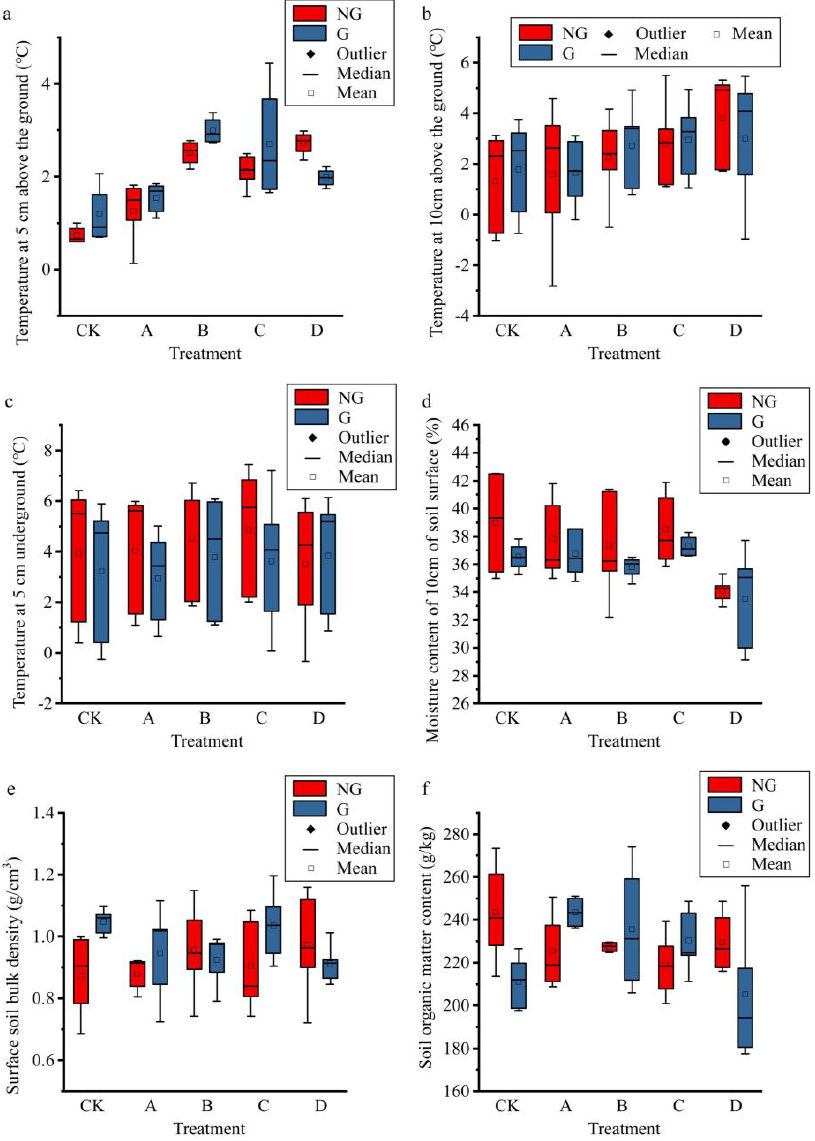
Figure 1. Changes in environmental factors in experimental treatments. ( a ), temperature at 5 cm aboveground; ( b ), temperature at 10 cm aboveground; ( c ), temperature at 5 cm